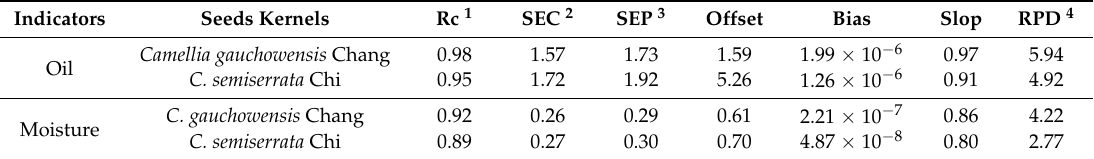
Table 2. Calibration and validation model parameters of oil and moisture contents by